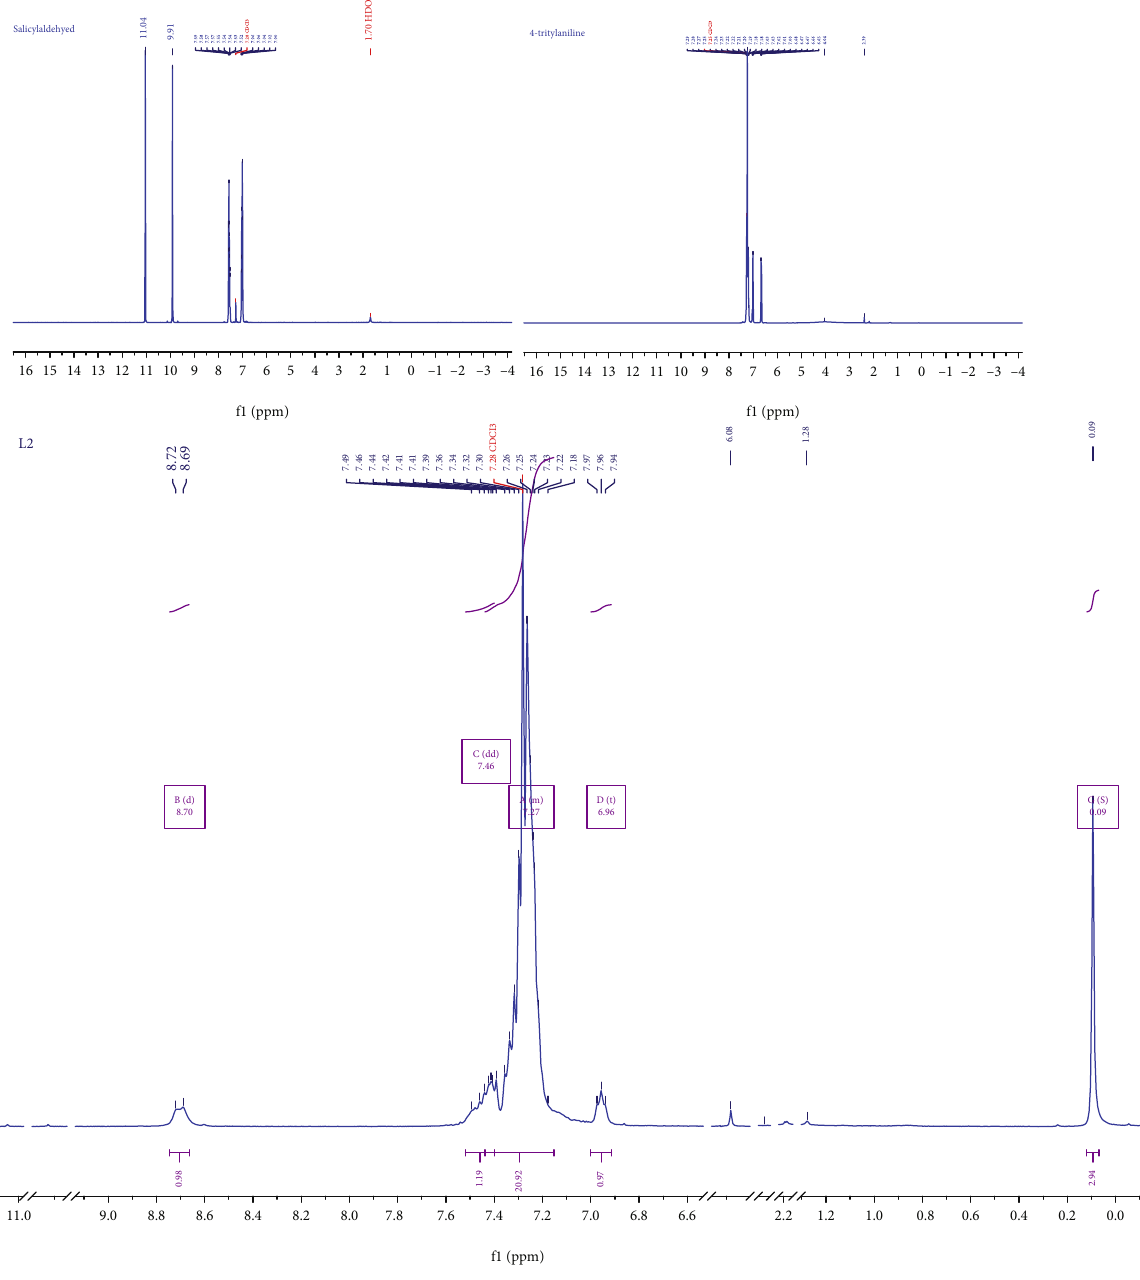
Figure 2: Comparison of magnetic resonance spectra nuclei of salicylic aldehyde, 4-tert-aniline, and ligand